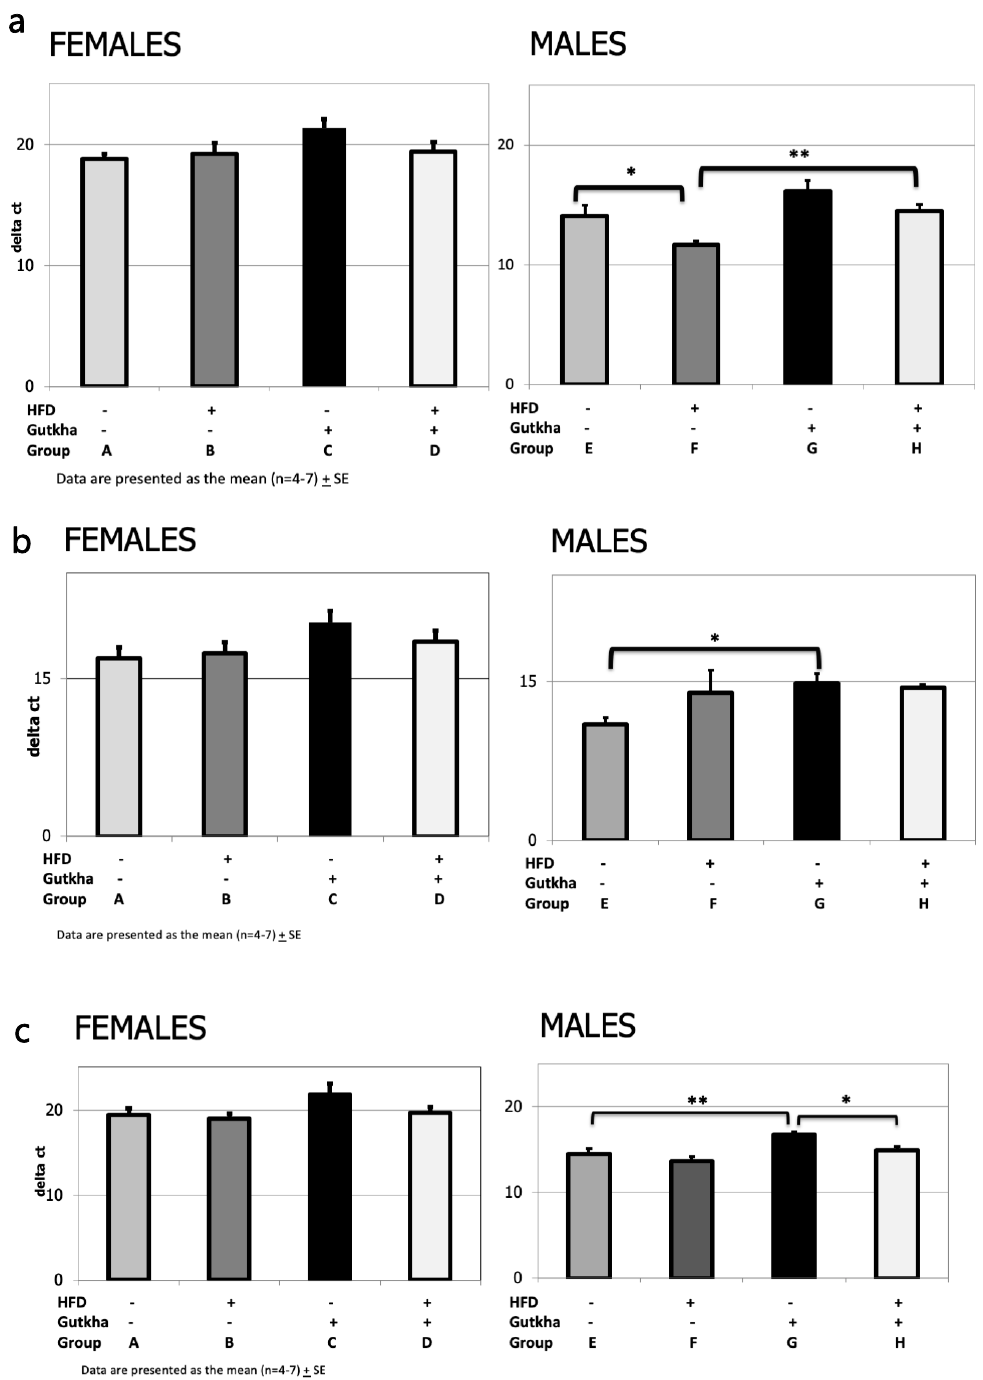
Figure 5. a – c. ( a ) Collagen 1 (Col1A1) mRNA gene expression is significantly (** p < 0.003) decreased